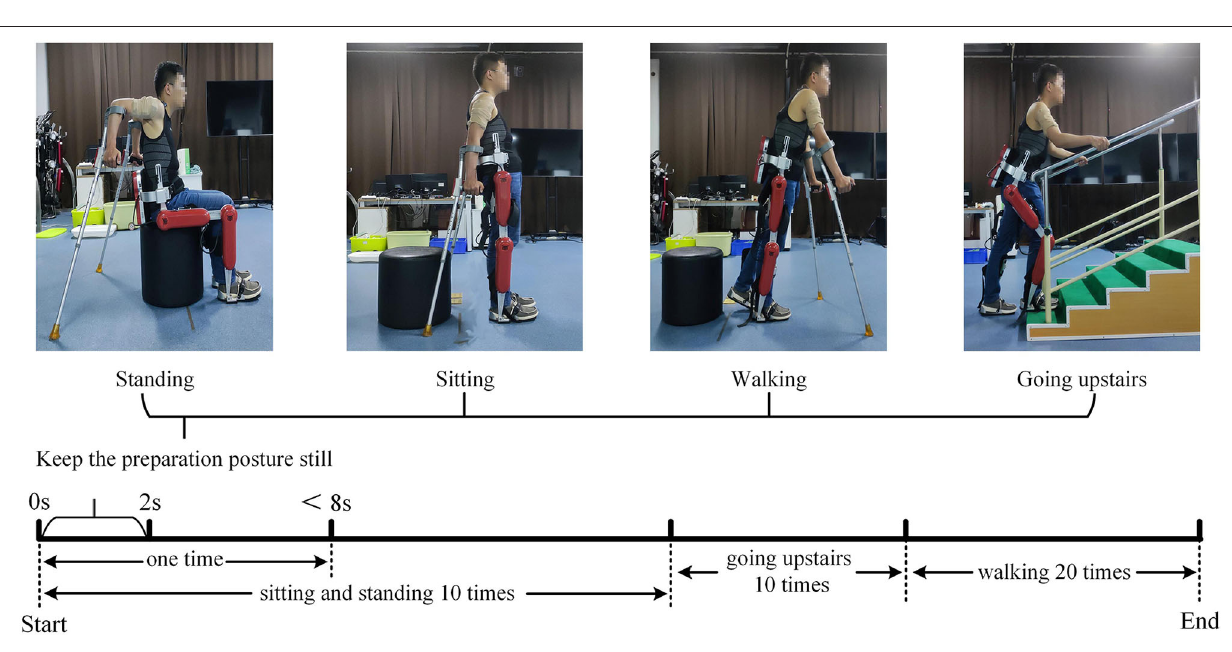
FIGURE 3 | Schematic diagram of surface electromyography (sEMG) data acquisition experiment. The upper part is the preparation posture of the four lower limb movements. We fixed the sEMG acquisition electrode with an elastic bandage to prevent the acquisition electrode from falling off during the experiment. The lower part is the schematic diagram of the experimental acquisition